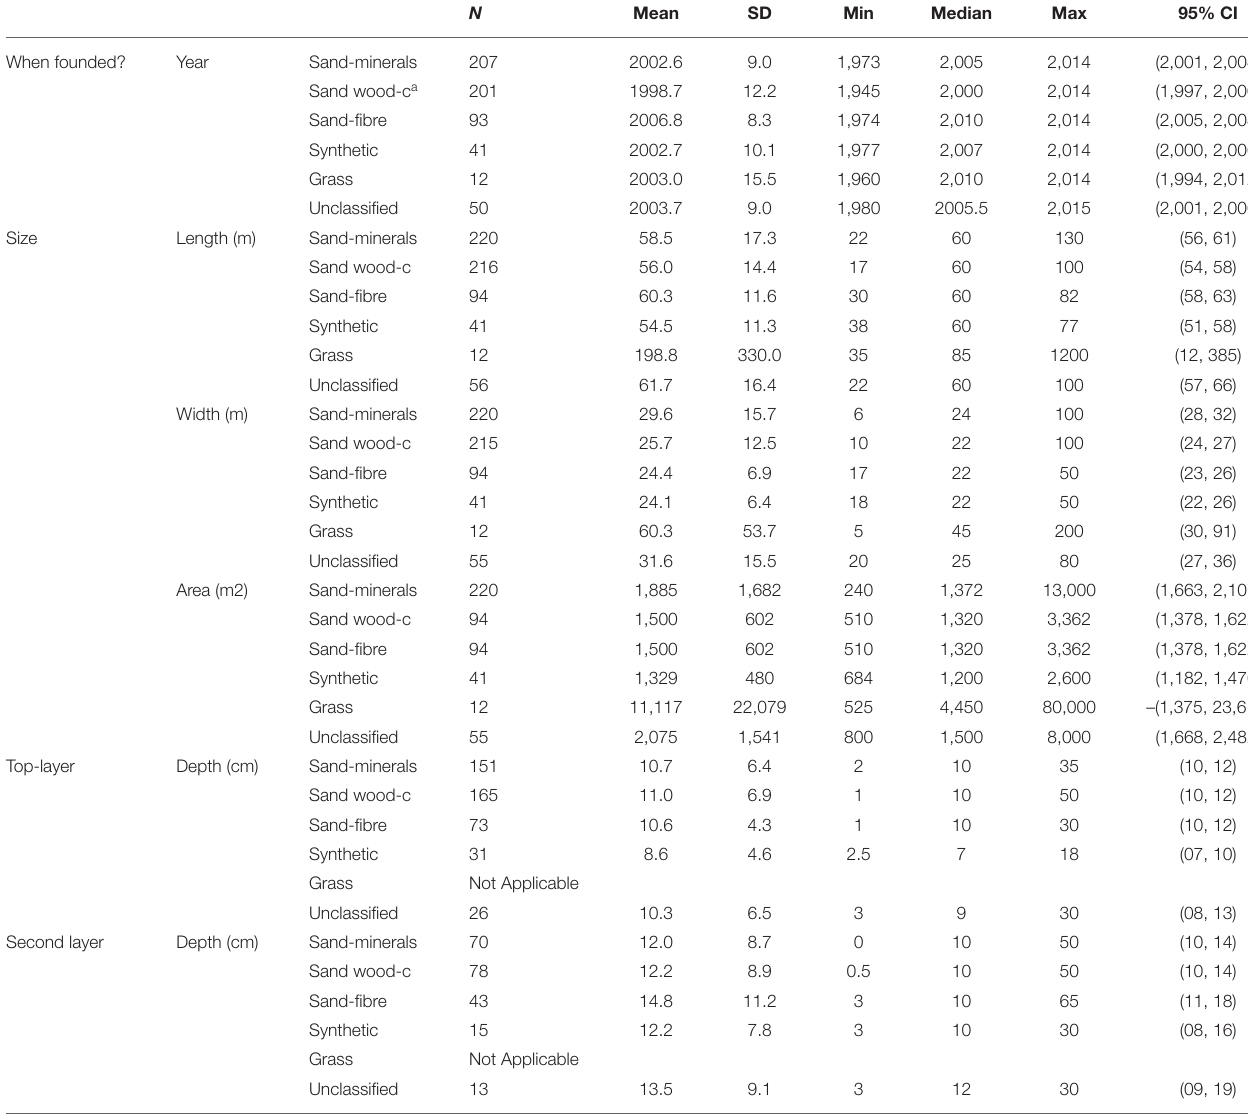
TABLE 3 | Data on age, size, and layer depth in arenas. N Mean SD Min Median Max 95%